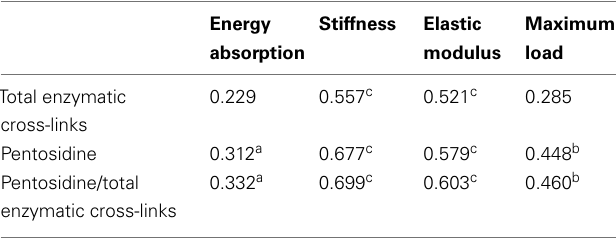
Table 1 |Association between collagen cross-link parameters and bone mechanical properties in the prediabetic and diabeticWBN/Kob